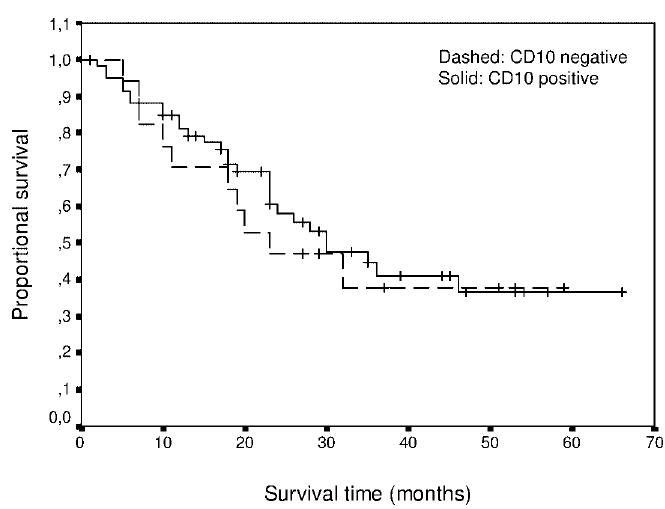
Fig. 2. Survival analysis: The Kaplan–Meier curve demonstrates no significant difference between CD10 positive and negative tumours. The mean survival time of CD10 negative tumours was 37 months compared to 32 months for CD10 positive tumours ( p = 0 .